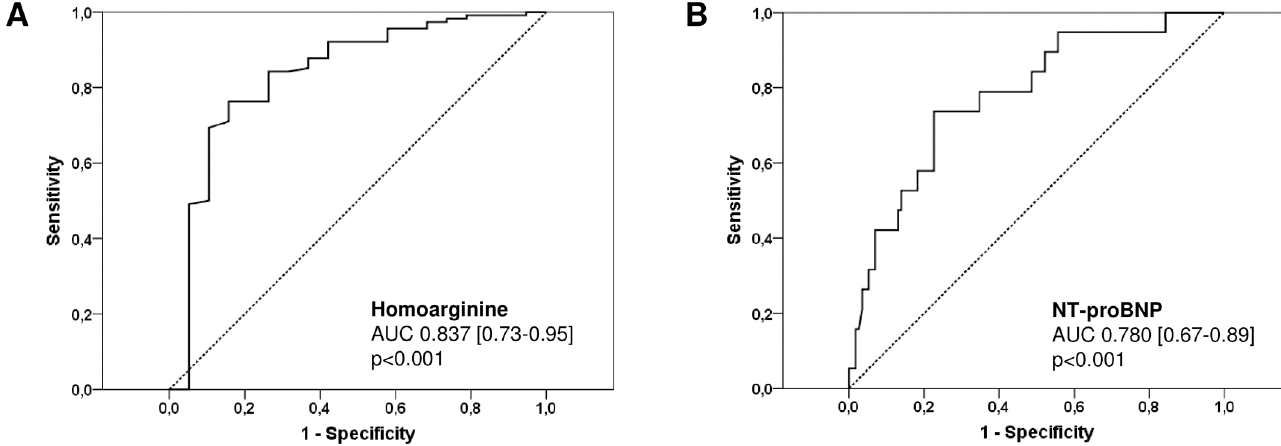
Fig 3. Receiver-operating characteristic (ROC) curves comparing sensitivity and specificity of hArg and NT-proBNP levels in predicting adversecardiac events in general. AUC, area under the curve.